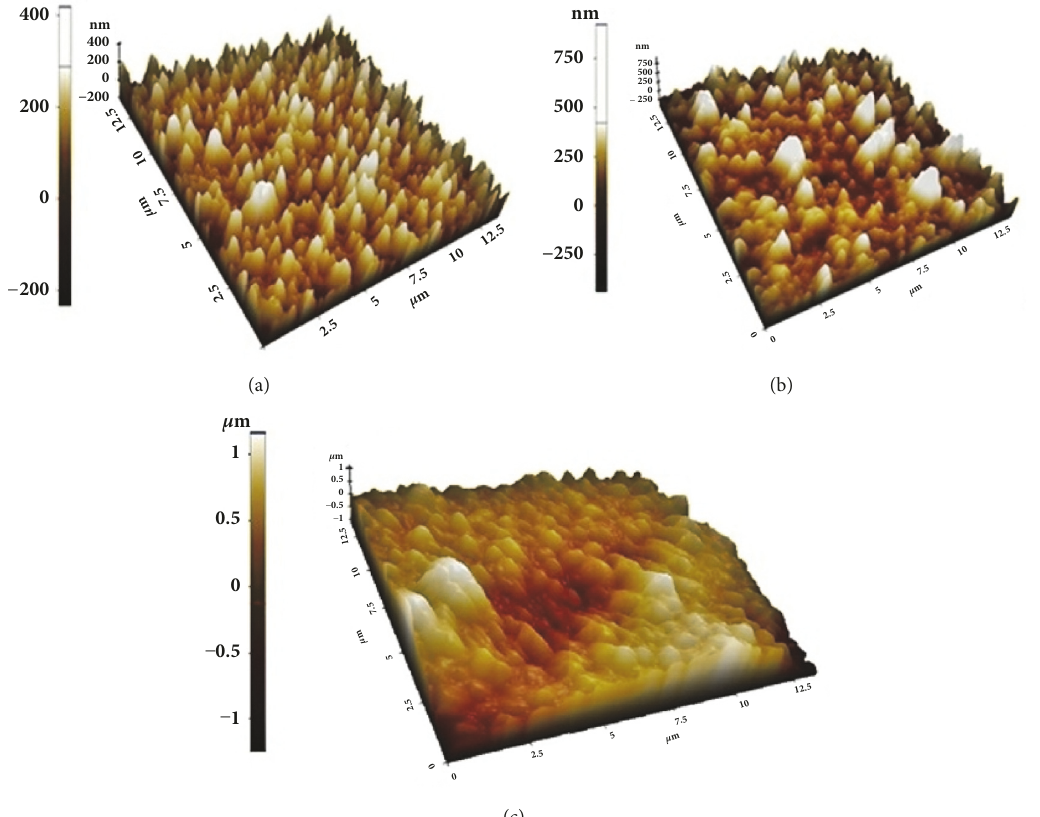
Figure 4: 3D AFM tapping mode images (12.5 𝜇 m × 12.5 𝜇 m) corresponding to (a) NIP film, (b) MIP film, and (c) overoxidized MIP film.